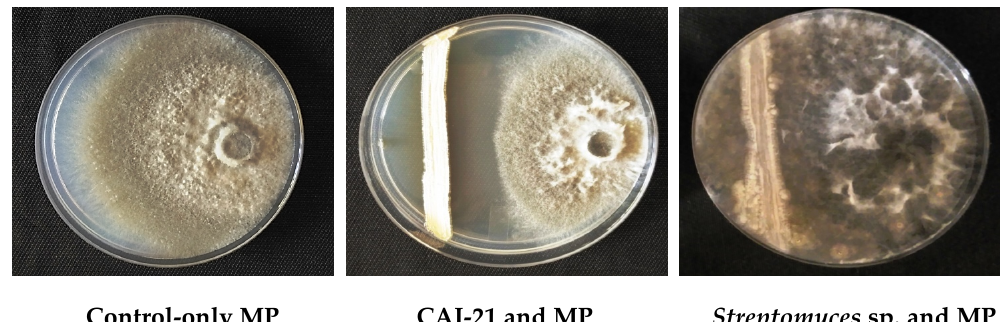
Figure 1. Growth inhibition of M. phaseolina (MP) caused by S. albus CAI-21 in comparison with non-inhibiting Streptomyces strain by dual-culture assay. Both MP and CAI-21 were plated on starch casein agar followed by incubation at 28 ± 2 °C for 120 h in the dark.